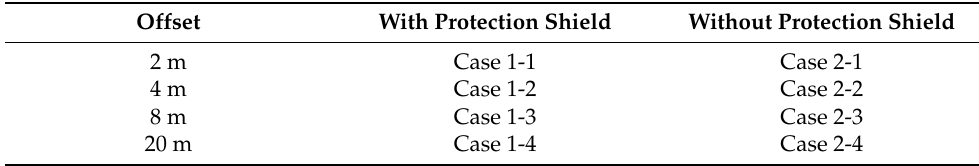
Table 3. Classification of numerical analysis cases.